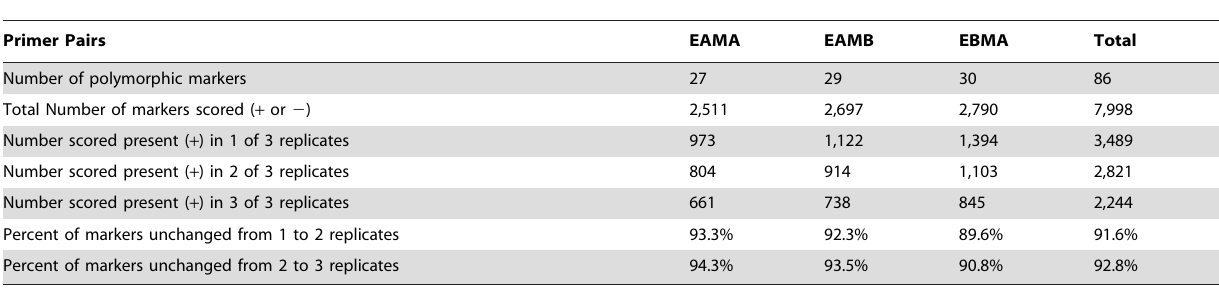
Table 2. Genotyping statistics for each AFLP selective primer pair.